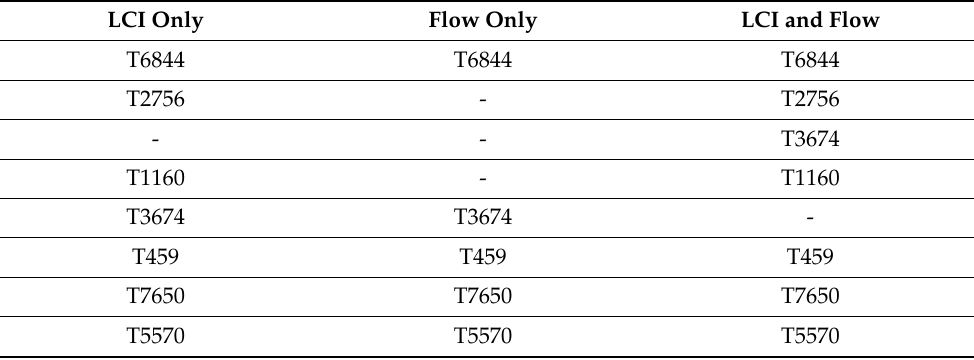
Table A5. Pipes on the red list in the service scenario from B calculated with different consequence